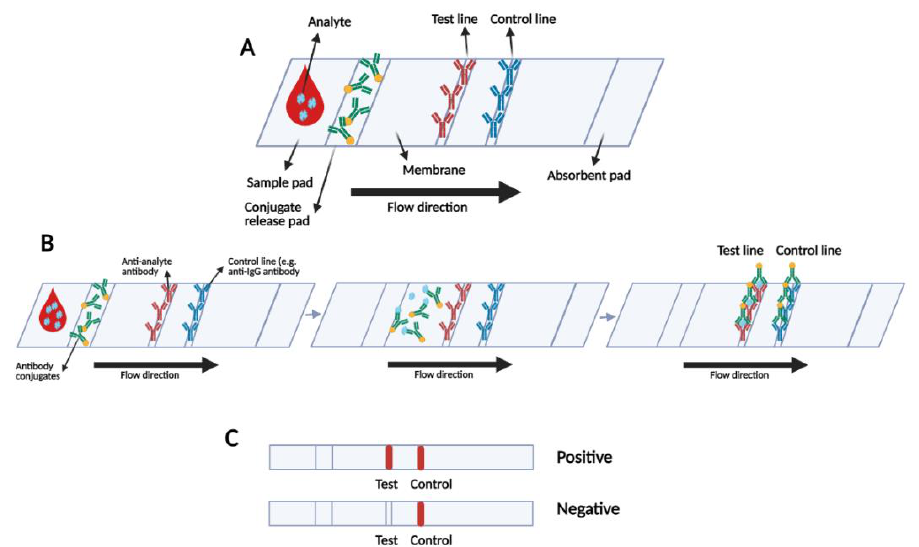
Figure 2. ( A ) Schematic of LFIA test strip; ( B ) mechanism of LFIA operation and ( C ) possible visual positive and negative results.